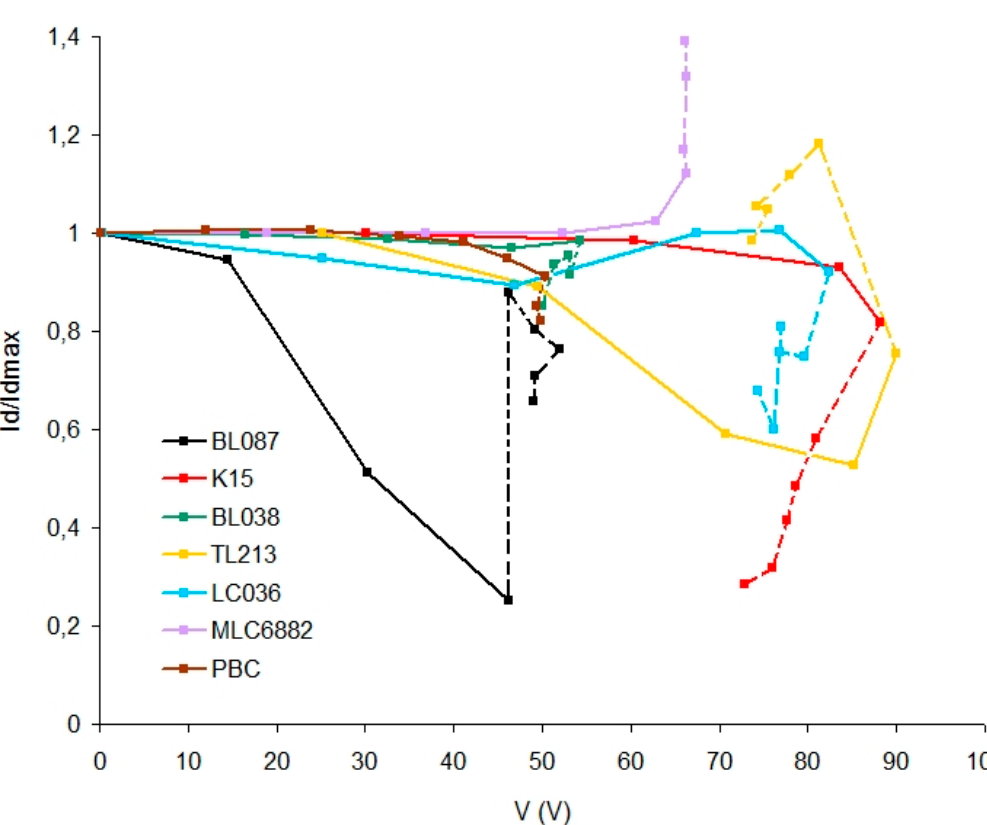
Figure 5. Diffracted light intensity divided by the maximum diffracted light intensity versus RMS voltage for each HPDLC device containing a different LC.